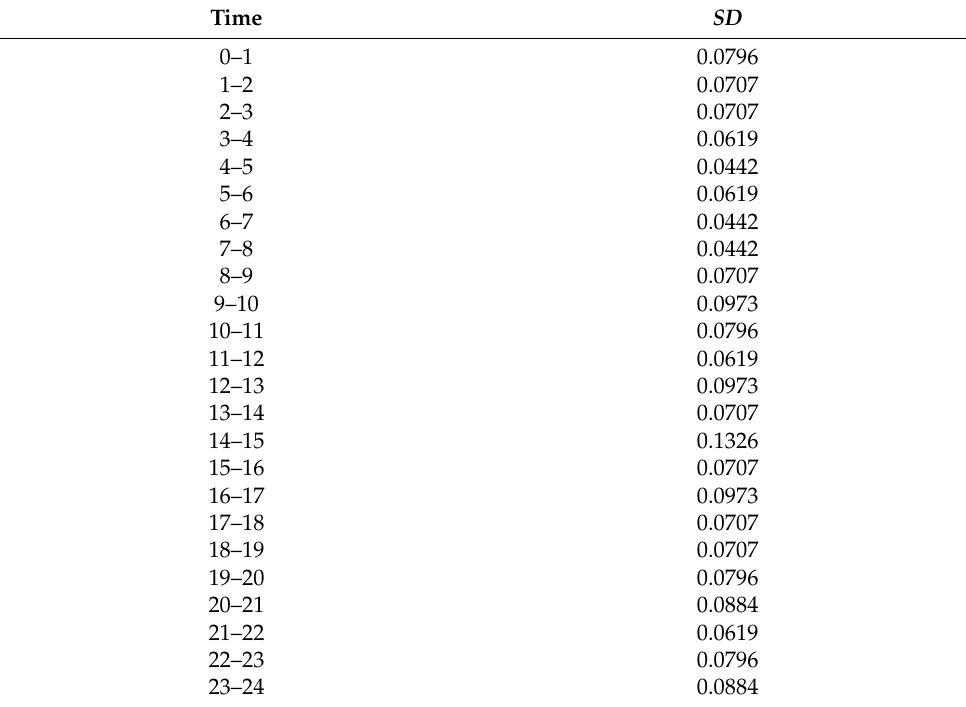
Table 4. The ship density for the studied PA.